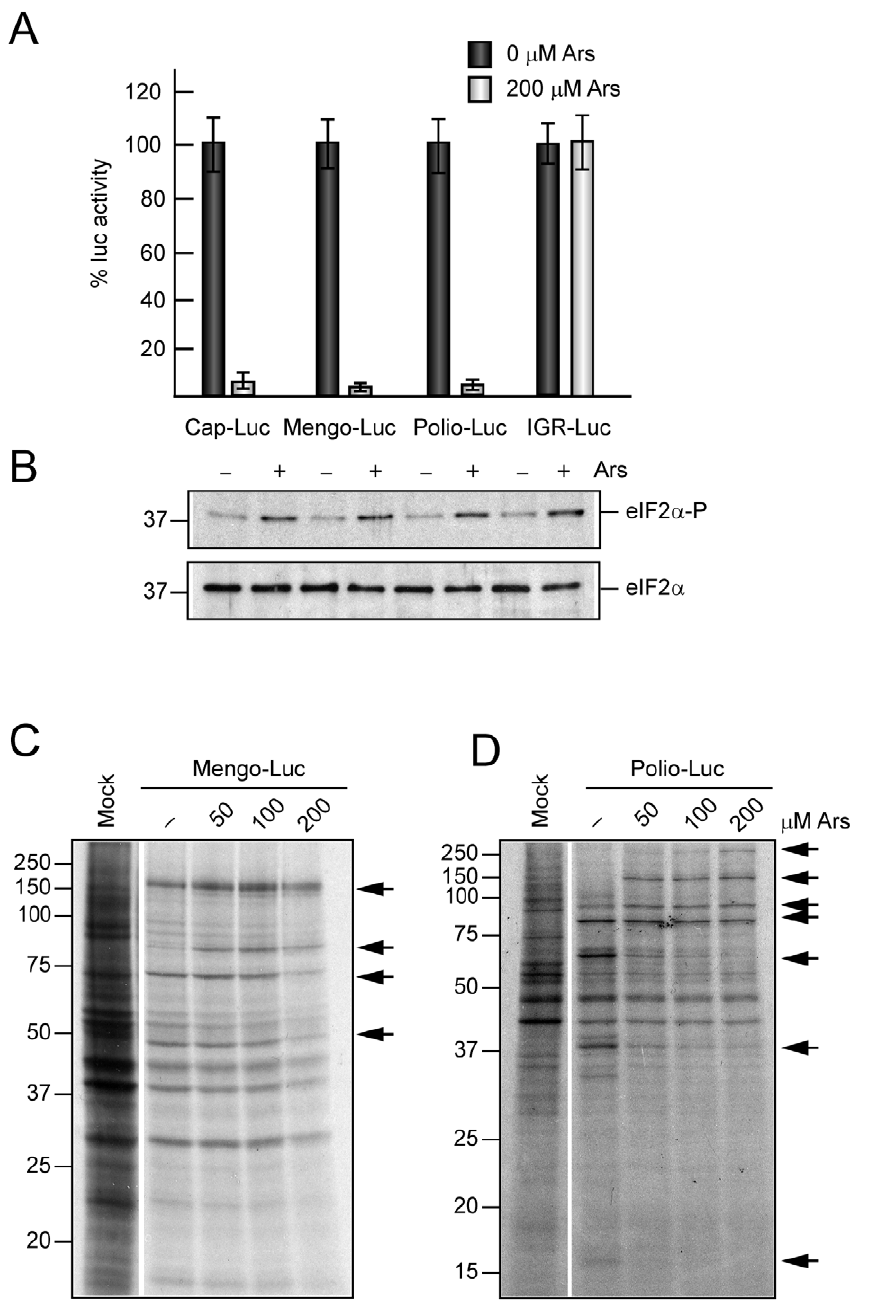
Figure 8. Translation of Mengovirus and PV replicons. Effect of Ars on early and late viral protein synthesis. A) BHK cells were electroporated with Mengo-luc, Polio-luc replicons, Cap-luc or CrPV IGR-luc mRNAs; all these RNAs were synthesized by in vitro transcription. Electroporated cells were seeded in DMEM (10% FCS) in presence or absence of 200 m M Ars. 75 min later cells were collected and lysed to measure luc activity. The values shown are percentages of the value of their respective Ars untreated samples and are means 6 SD of three independent experiments. B) The phosphorylated form of eIF2 a and total eIF2 a were determined in parallel by Western blot with specific antibodies. C and D) BHK cells were electroporated with Mengo-luc replicon (C) or polio-luc replicon (D) and at 5 h post-electroporation protein synthesis was determined by [ 35 S]Met-Cys labelling in presence of different concentrations of Ars (0, 50, 100 and 200 m M). The arrows indicate viral proteins.